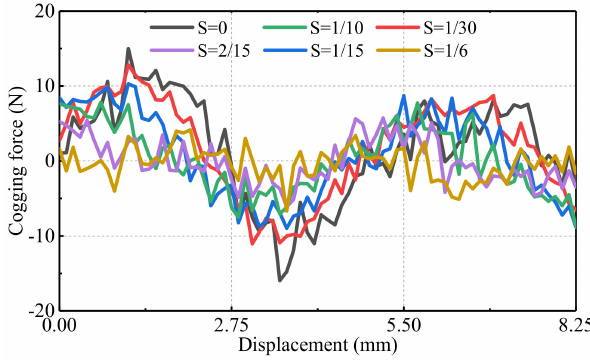
Figure 9. Cogging forces of the DSPMLSM with different S